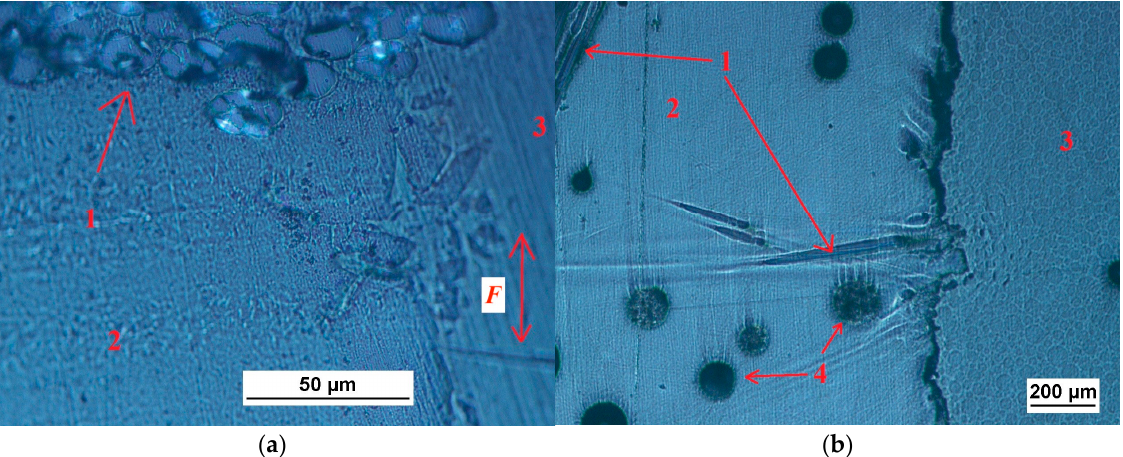
Figure 1. The examples of the specimens: ( a ) made of MC-DUR 1200VK epoxy resin with an emulsion binder glass reinforcement and no addition of quartz powder; ( b ) made of Sikafloor 156 epoxy resin with a powder binder glass reinforcement and the addition of 6 wt.% quartz powder.